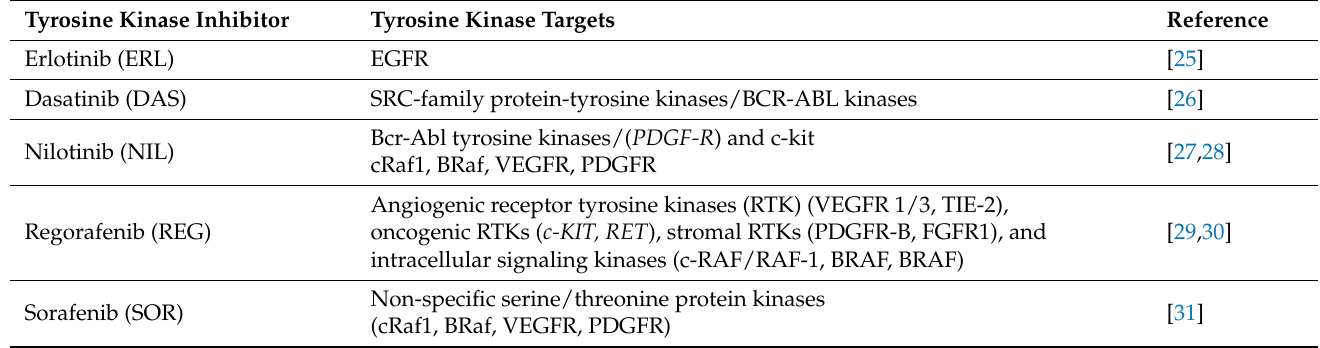
Table 1. Summary of tyrosine kinase inhibitors and their molecular